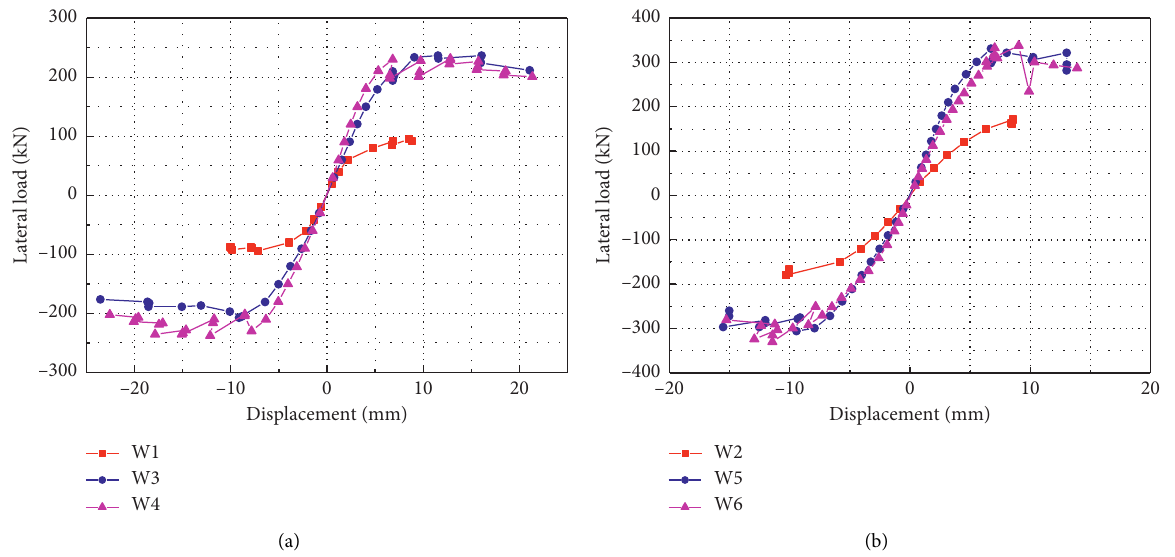
Figure 9: Envelope curves of specimens: (a) W1, W3, and W4; (b) W2, W5, and